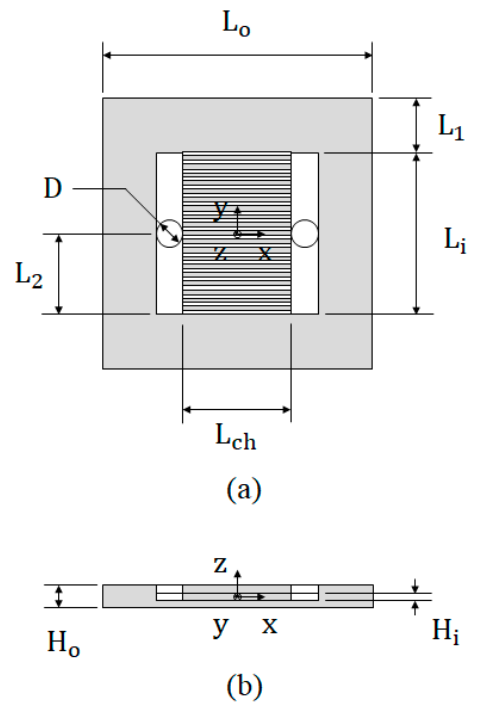
Figure 3. Geometric configuration of the I-type microchannel heat sink: ( a ) top view and ( b ) side view.